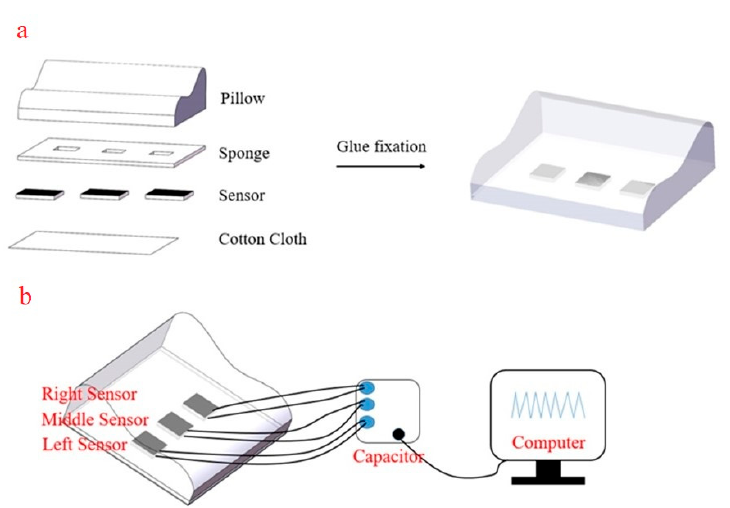
Figure 10. ( a ) Schematic of the three flexible sensors placed beneath the pillow, ( b ) test circuit diagram of the smart pillow.